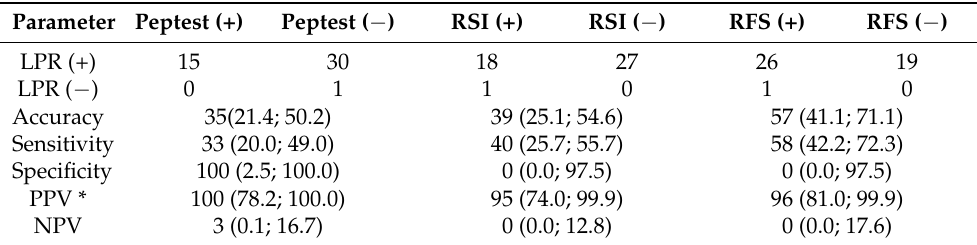
Values are the number of patients or diagnostic measure with the 95% confidence interval, as indicated. RSI— Reflux Symptom Index, RFS—Reflux Finding Score, LPR—laryngopharyngeal reflux, PPV—positive predictive value, NPV—negative predictive value. *—important result. Table 3. Diagnostic evaluations of the Peptest, RSI, and RFS in patients with (+) or without ( − ) a laryngopharyngeal reflux diagnosis based on a threshold of six hypopharyngeal reflux episodes. Parameter Peptest (+)